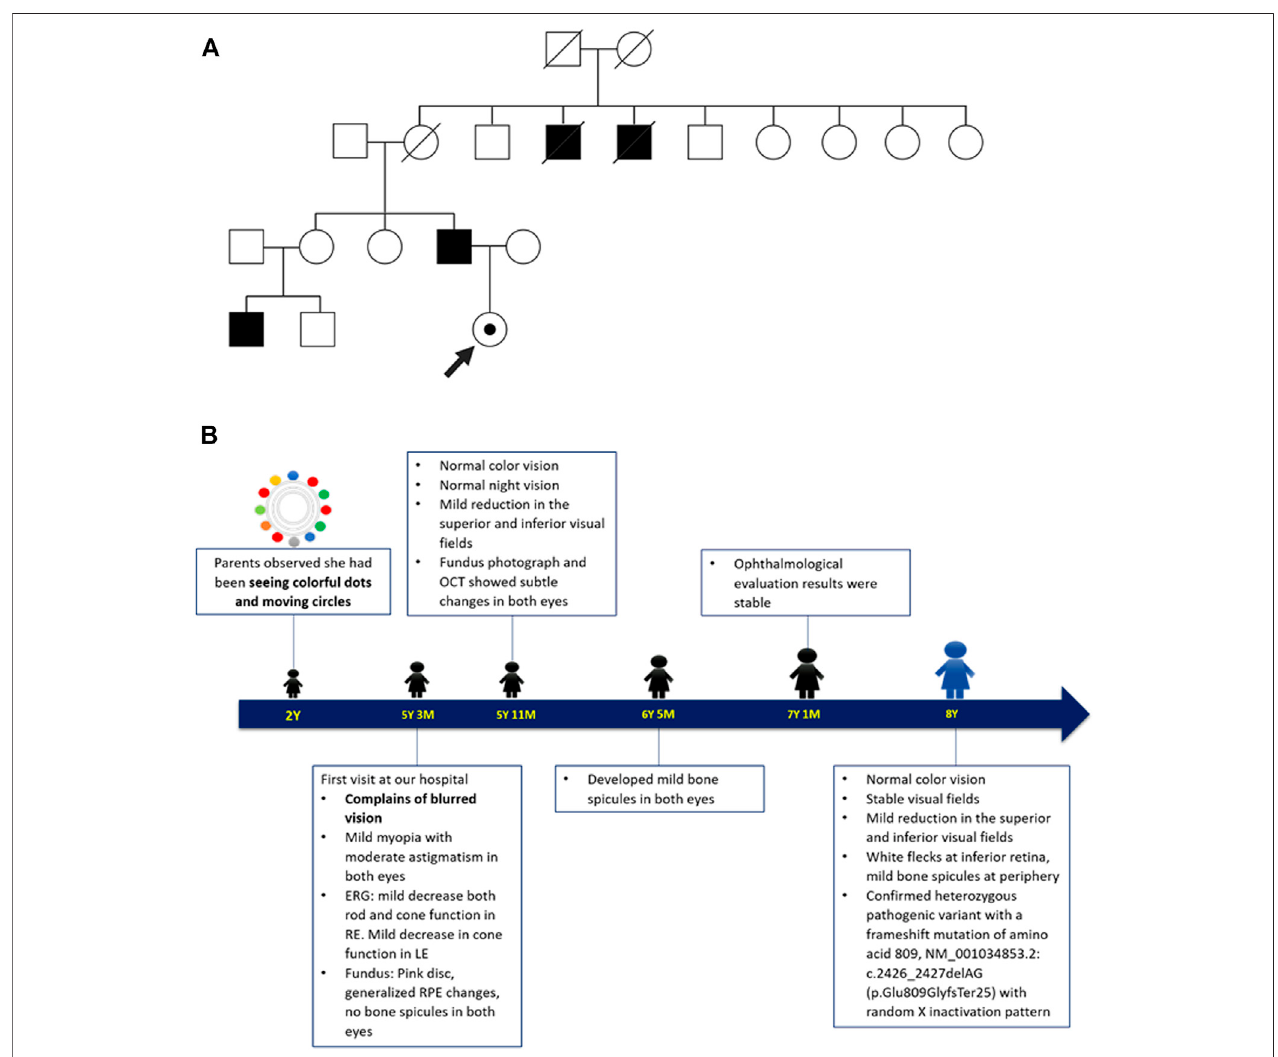
FIGURE3|(A) Thepatient ’ sfamilypedigree.Thepedigreewasdrawnbasedonthefather ’ sdescriptionontheirfamilymemberspresentingsymptomssuggestive of XLRP. Circles indicate female and squares indicate male. Close symbols indicate family members with symptoms and open symbols indicate unaffected individuals. The dotted circle indicates the patient as a female carrier. The strike-through symbols indicate deceased family members. (B) Timeline of patient care. The patient ’ s parents fi rstnoticedherseeingcolourfulmovingdots,possiblyrepresentingvisualsnow,attheageof2 years.She fi rstcameforophthalmologicalevaluationatthe age of 5 years due to blurred vision. The follow up was performed fi ve times over the course of 3.5 years, where the patient displayed signi fi cant reduction of the cone function in both eyes. The mutation analysis and the X-chromosome inactivation study were performed at the age of 8 years.